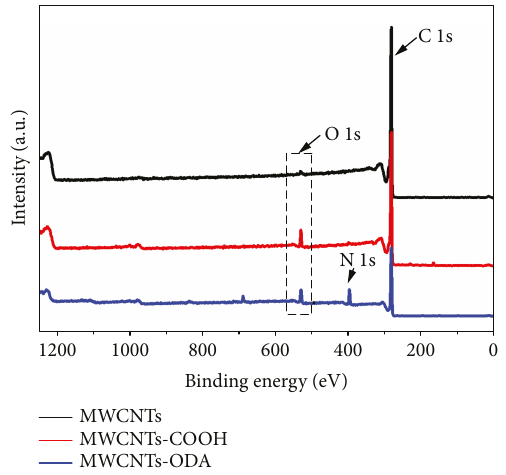
Figure 2: XPS spectrum of MWCNTs, MWCNTs-COOH, and